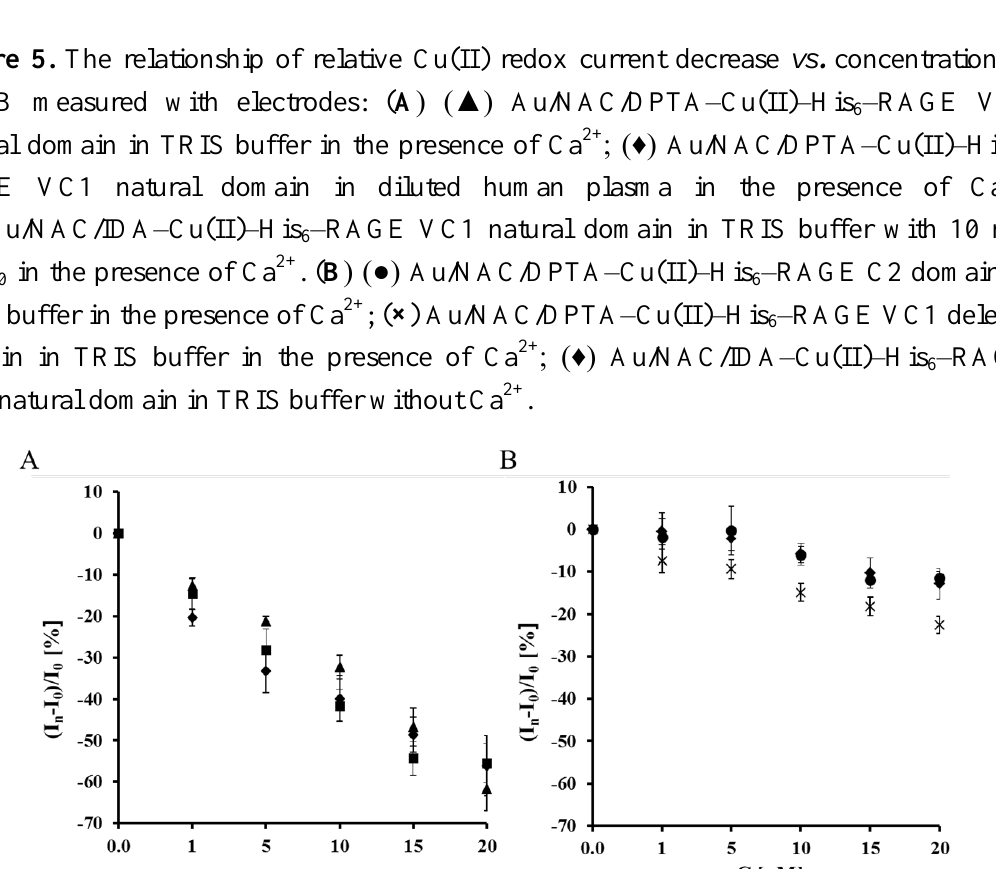
–RAGE VC1 6 – 6 –RAGE C2 domain in 6 –RAGE VC1 deleted 6 –RAGE 6